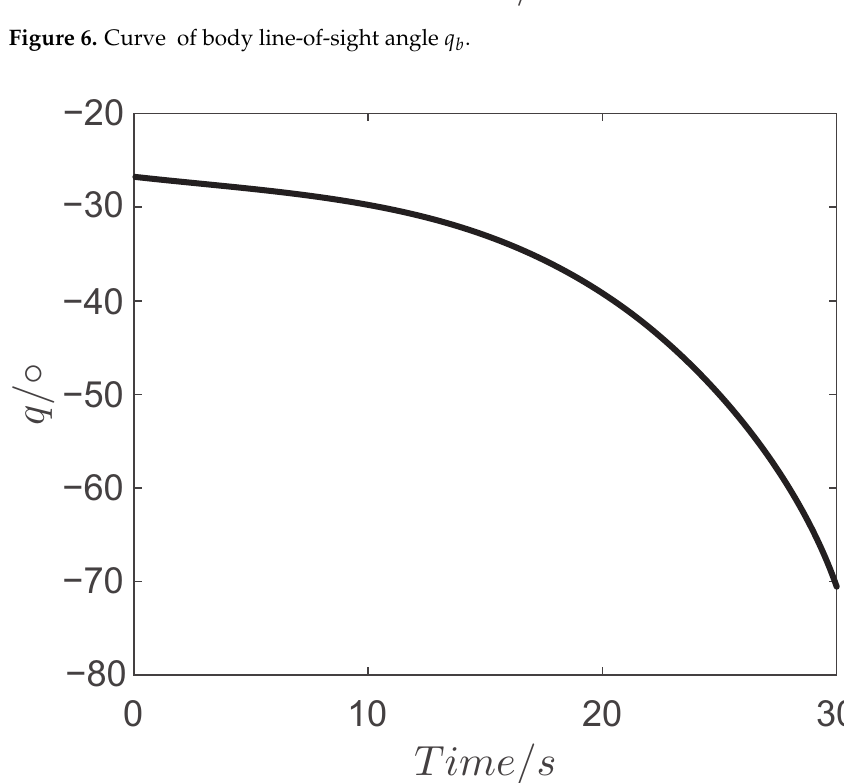
Figure 7. Curve of line-of-sight angle q